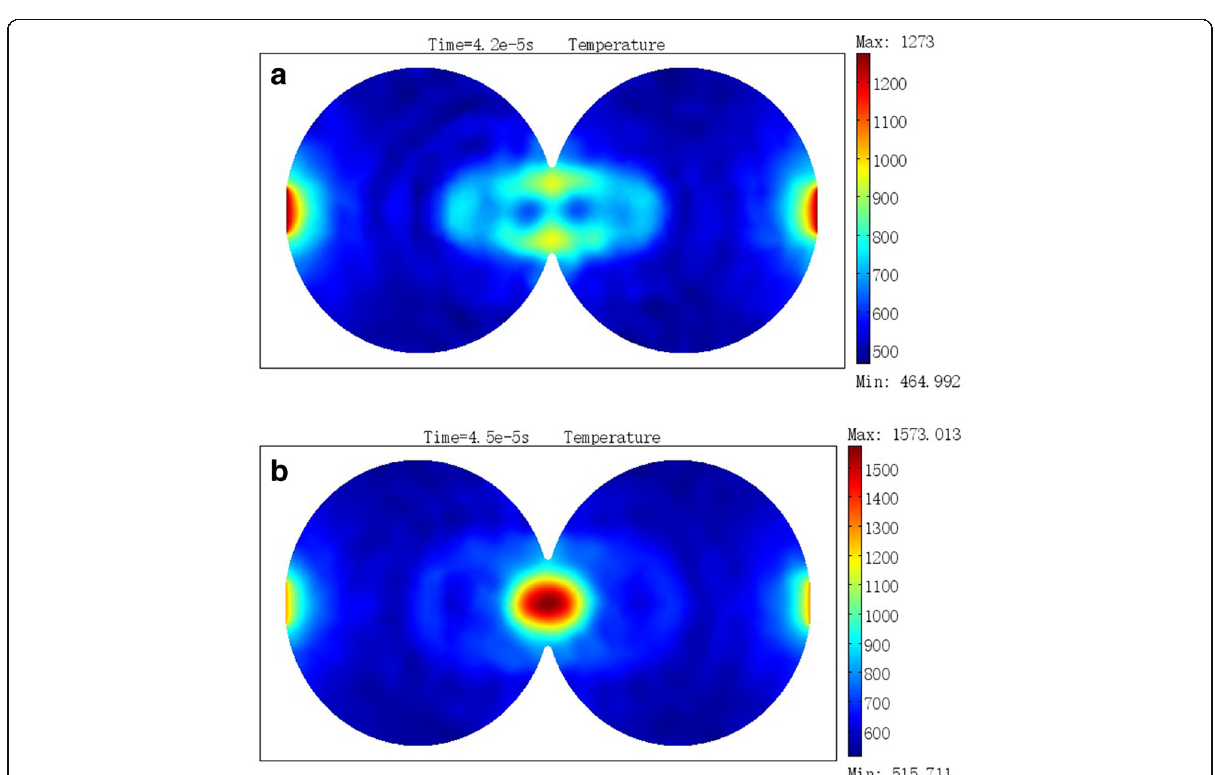
Fig. 2 Temperature distribution. a t = 4.2e − 5 s, section xoy temperature distribution. b t = 4.5e − 5 s, section xoy temperature